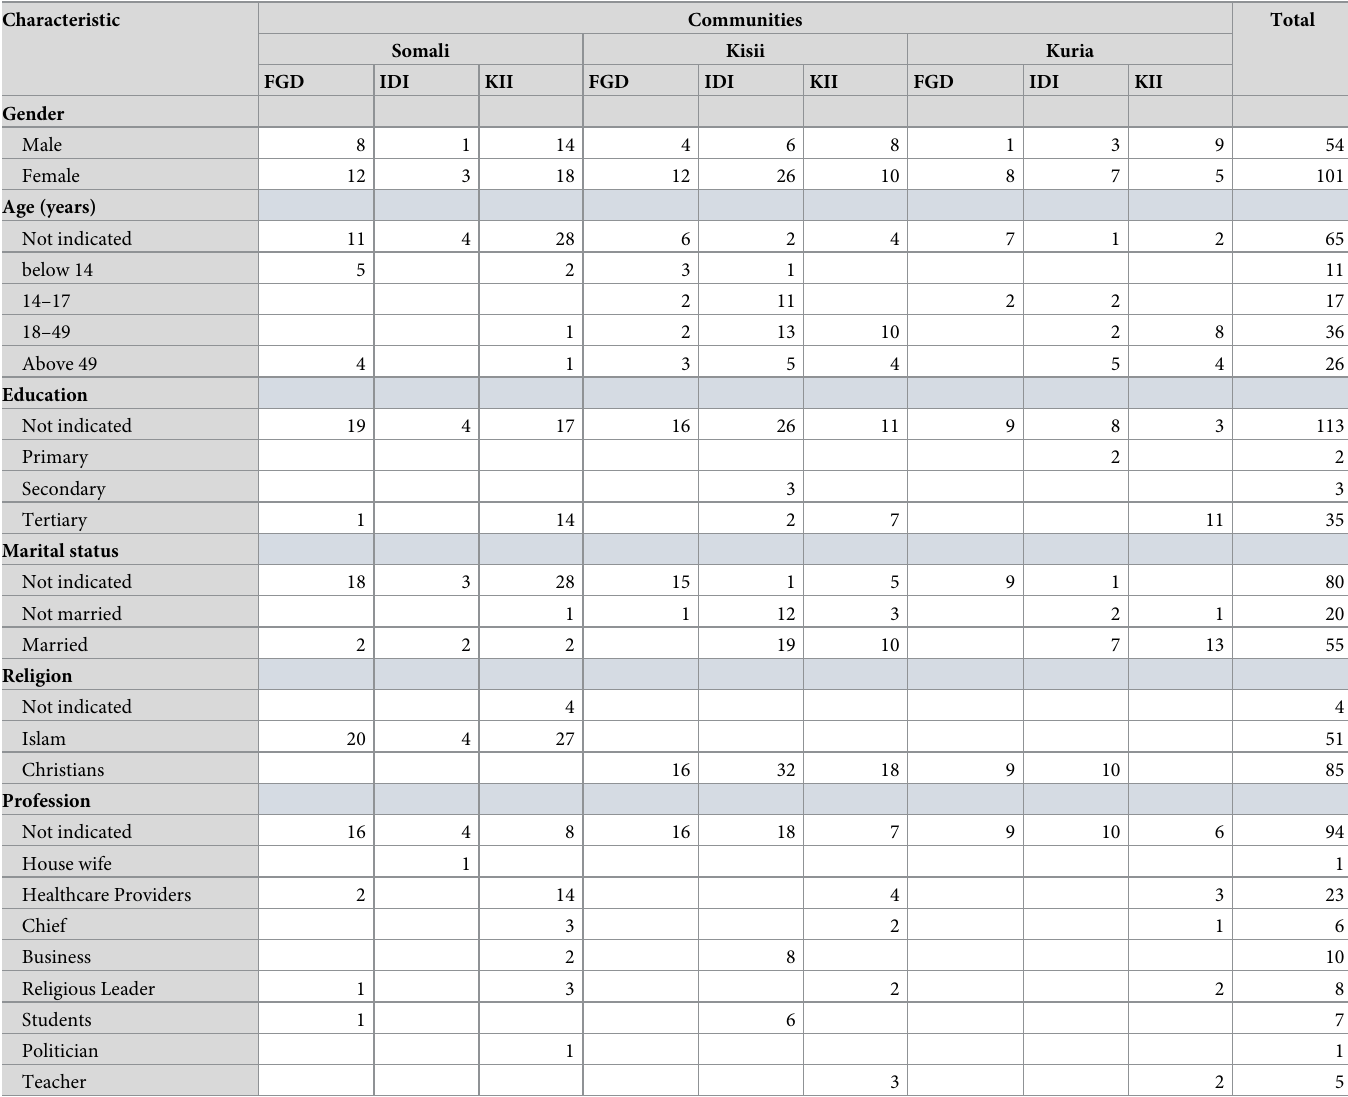
Table 1. Demographic characteristics of study participants by interview